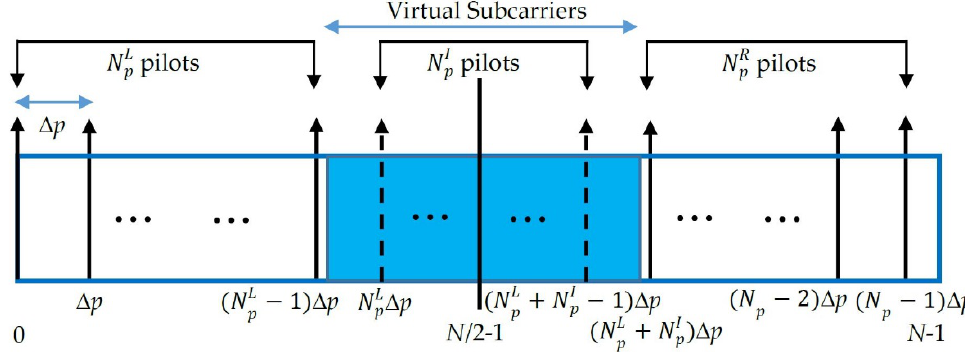
Figure 1. Schematic diagram of the arrangement of OFDM system pilot signals. Table 1. Parameter definitions. Parameter Meaning N The number of FFT points. The spacing between pilot subcarriers. The number of pilot subcarriers on the left of the virtual subcarrier